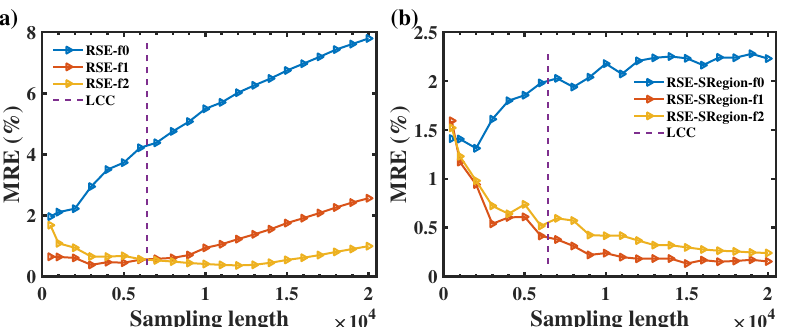
Figure 11. Variation of the mean relative error (MRE) and mean square error (MSE) with the sampling length and flattening order. ( a ) MRE obtained by using the RSE algorithm without scaling region interception, ( b ) MRE with scaling region